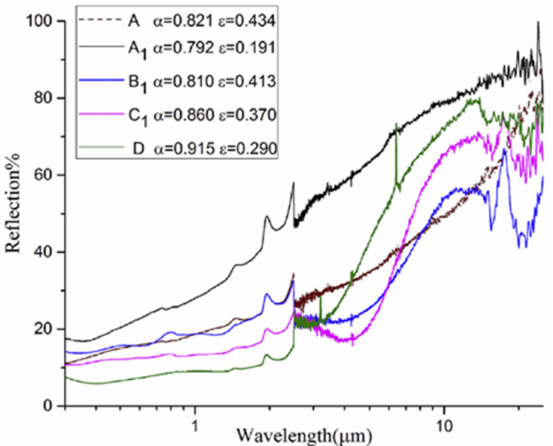
Figure 7. Reflectance curves: A—multimodal WC-Co layer; A1—polished WC-Co layer; B1—WC-Co + CuCoMnO x layer; C1—WC-Co + CuCoMnO x + CuCoMnO x + SiO 2 layer; D—WC-Co + CuCoMnO x + CuCoMnO x + SiO 2 + SiO 2 , reproduced from [35], with permission of Elsevier 2018.